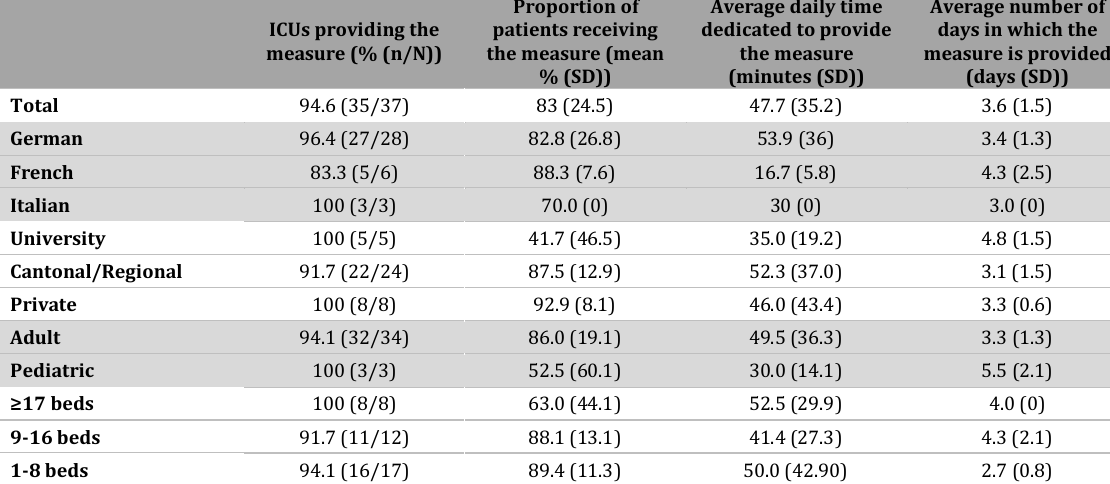
Table S13. Sitting on the edge of the bed